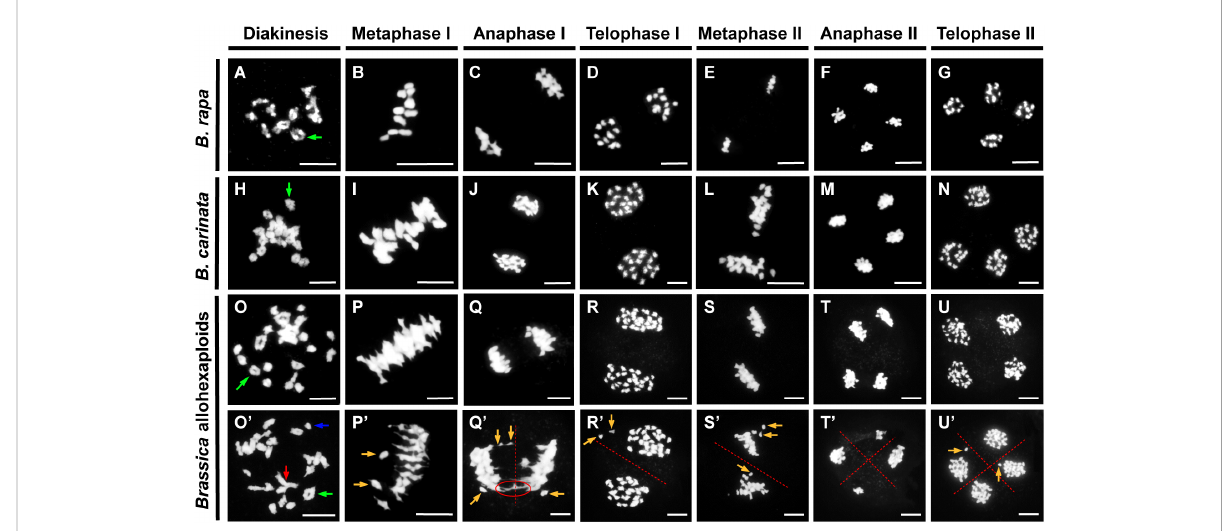
FIGURE 3 Meiotic chromosome behavior in B. rapa , B. carinata and Brassica allohexaploids. Normal meiosis processes in B. rapa (A – G) , B. carinata (H – N) and Brassica allohexaploids (O – U) . (O ’– U ’ ) Abnormal chromosome behavior of pollen mother cells (PMCs) in the Brassica allohexaploid plants. The green arrow indicates a normal bivalent; the blue arrow indicates a univalent; the red arrow indicates a multivalent; and the brown arrow indicates a lagging chromosome. The chromosome bridge is indicated with a red ellipse. Bars = 10 µm.